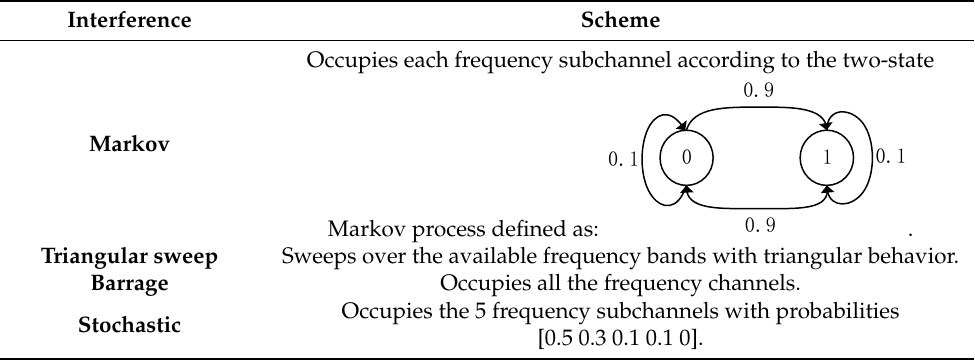
Table 1. Active interference activity schemes in the frequency domain.